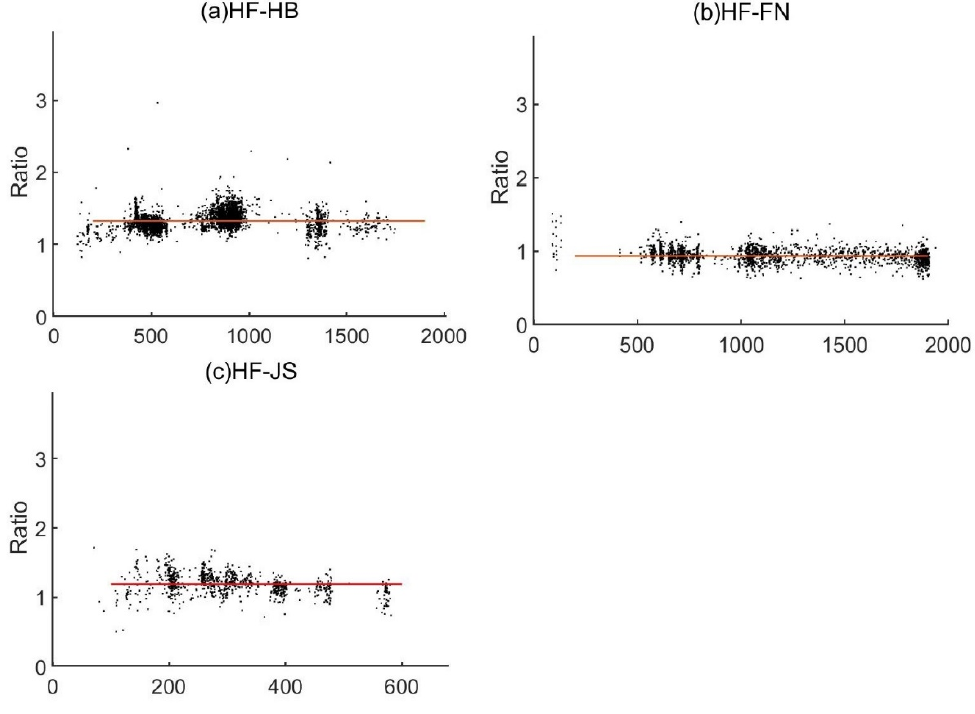
Figure 8. ( a ) Observations of field gain at equal distance for the HF–HB station link. ( b ) Observations of field gain at equal distance for the HF–FN station link. ( c ) Observations of field gain at equal distance for the HF–JS station link.